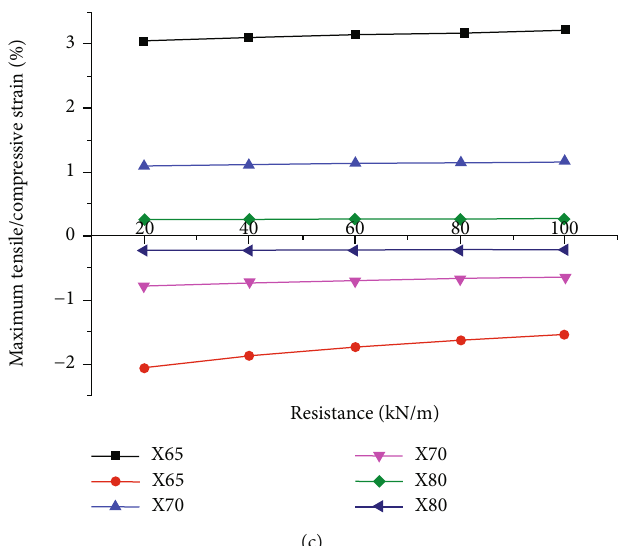
Figure 14: Relationship between maximum tensile and compressive strains and soil spring resistance of unfrozen soils: (a) vertical uplift peak soil resistance, (b) vertical bearing peak soil resistance, and (c) axial peak soil